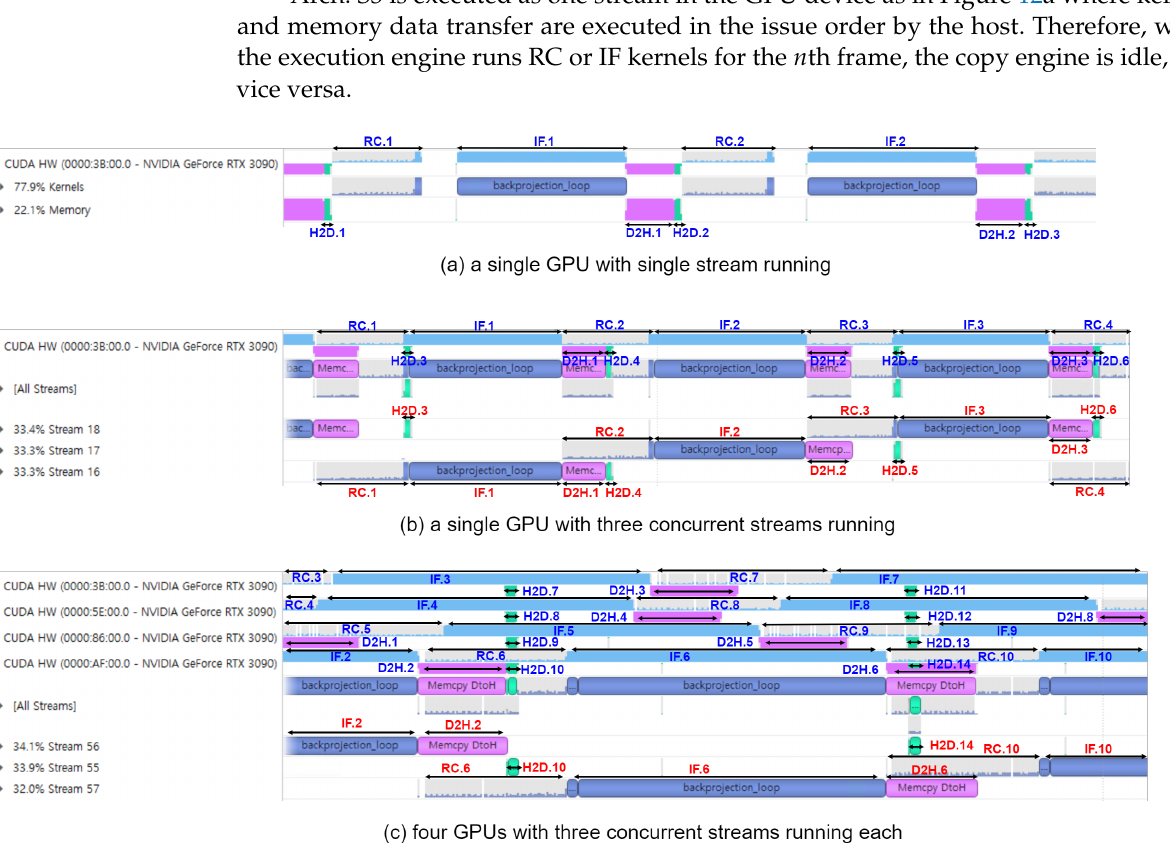
Figure 12. Visual profiling results of Arch. S3 and its multi-stream and multi-GPU extensions. Suffix n of H2D. n , RC. n , IF. n , D2H. n represents the BP-VISAR frame number. Target frame resolutions are 2048 × 2048 for ( a , b ) and 4096 × 4096 for ( c ),